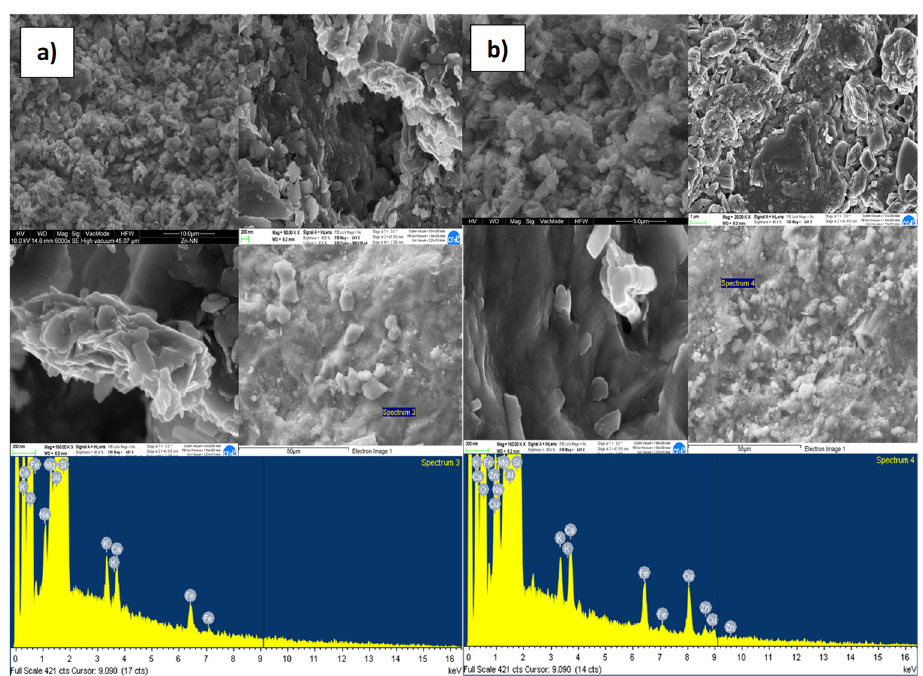
Figure 8. FESEM and EDX microphotographs of the mordenite natural zeolite, ( a ) inlet of the column. ( b ) Outlet of the column.